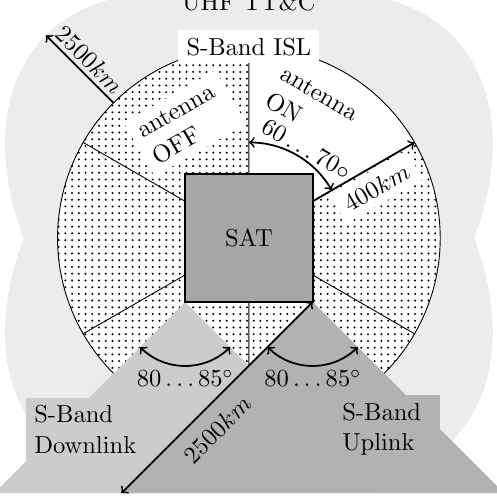
Figure 13. Antenna characteristics for UHF and Sband